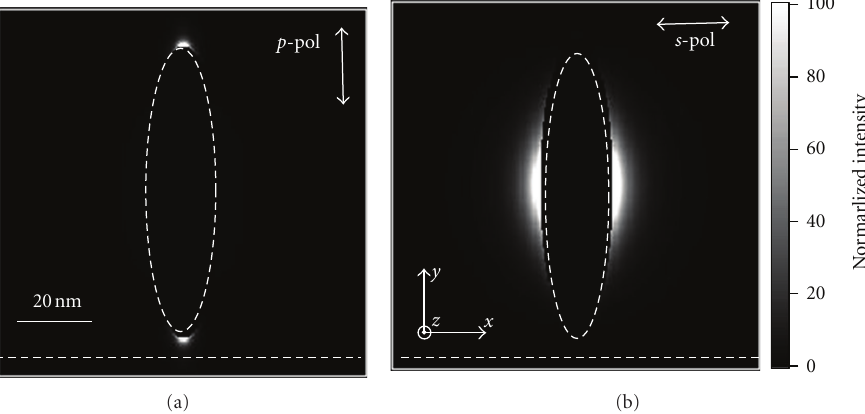
Figure 2: Theoretical calculation of electric field distributions near an ellipsoidal metallic nanoparticle under (a) p -polarization and (b) s - polarization excitations. The horizontal dotted lines indicate the sample surface. Strong field confinement can be seen near the apex between the sample and the probe in p -polarization, which is almost negligible in s